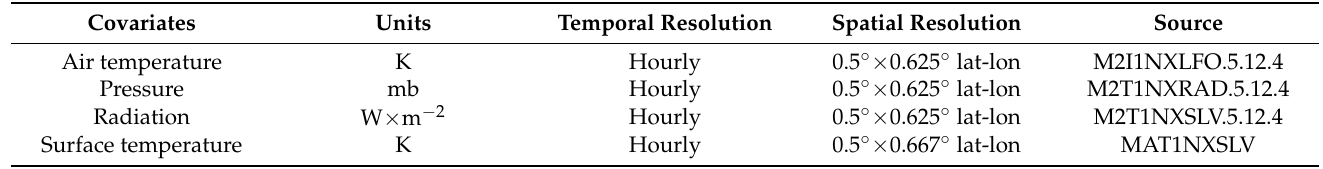
Table 2. Meteorological data